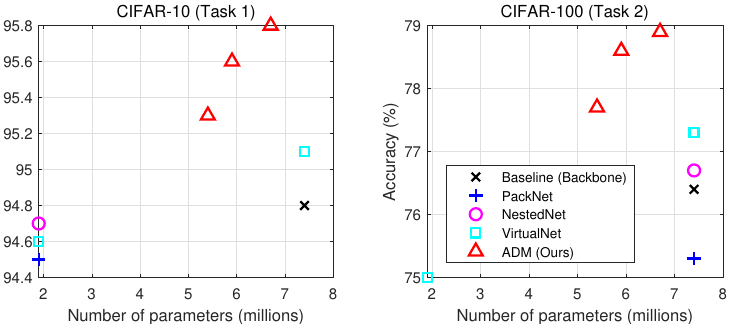
Figure 4. Classification results of the multi-task problem using the CIFAR-10 and CIFAR-100 datasets (two tasks). All the methods are based on the WRN-32-4 architecture, consuming 7.4 million